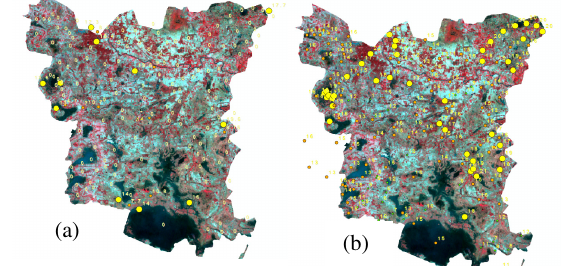
Fig.7 Village locations (a) Observed MHD and (b) predicted MHD overlaid on IRS satellite data of Patepur Block, Vaishali